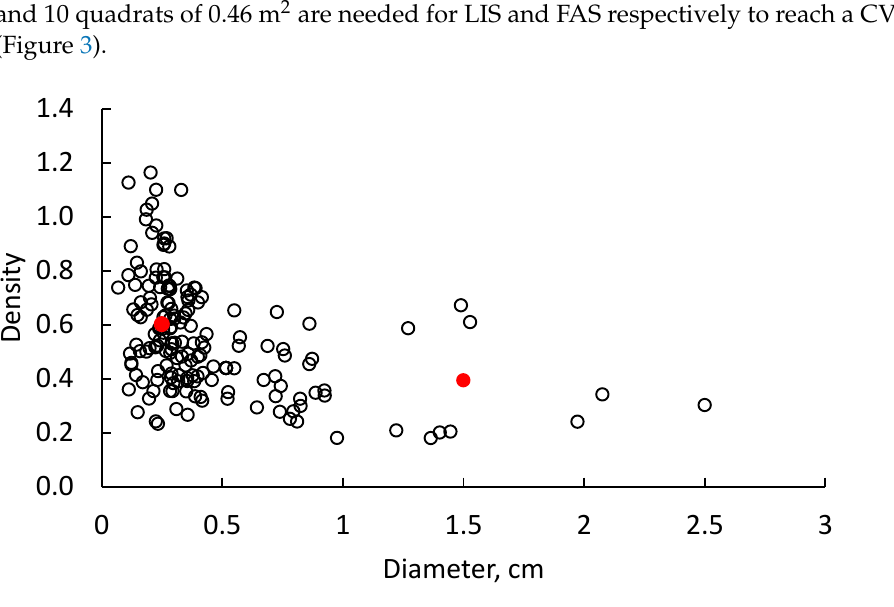
Figure 4. Density of fine woody debris (FWD) pieces in the Pilot Stand versus their measured diameter (n = 172), and mean density of the two diameter classes (red dots): 0–0.5 cm and 0.5–4 cm. Table 3. Fine woody biomass estimated according to plot size and method: the fixed-area sam- pling method (FAS: simple: 0.46 and double: 0.92 m 2 , n = 40) and line-intersect sampling method (LIS: simple: 0.7 m and double: 1.4 m, n = 75 in the Test Zone, and 0.5 and 1 m in the Pilot Stand, n = 15) and results of statistical tests.